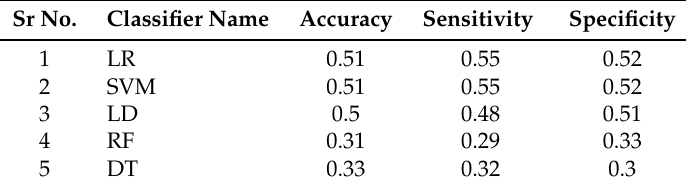
Table 9. 10-Fold Results based on the Top 2000 Selected Features based on Proposed 3-Stage Approach. Sr No.